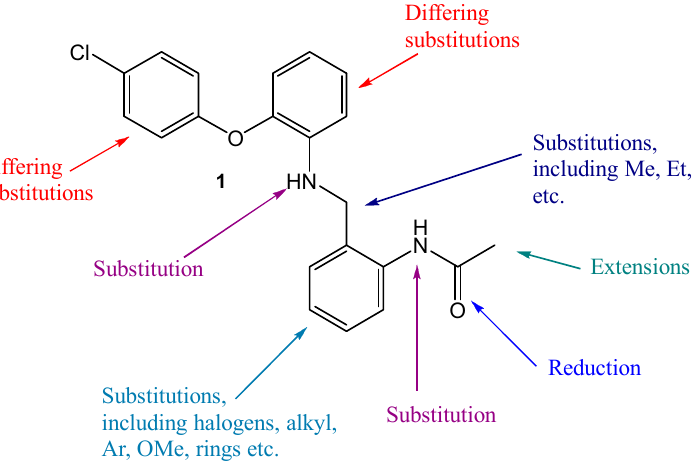
Figure 4. Scope of substitution on lead novel benzylamine, compound 1.